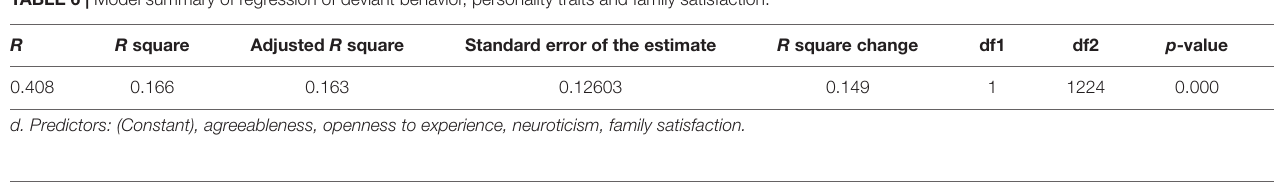
TABLE 7 | Relationship of deviant behavior, personality traits, and family satisfaction.